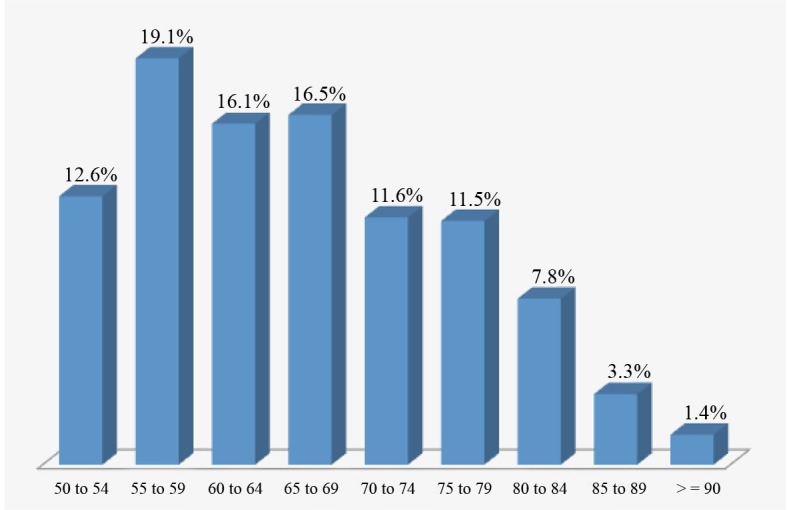
Distribution of sample by age group. Source: Database used for study.